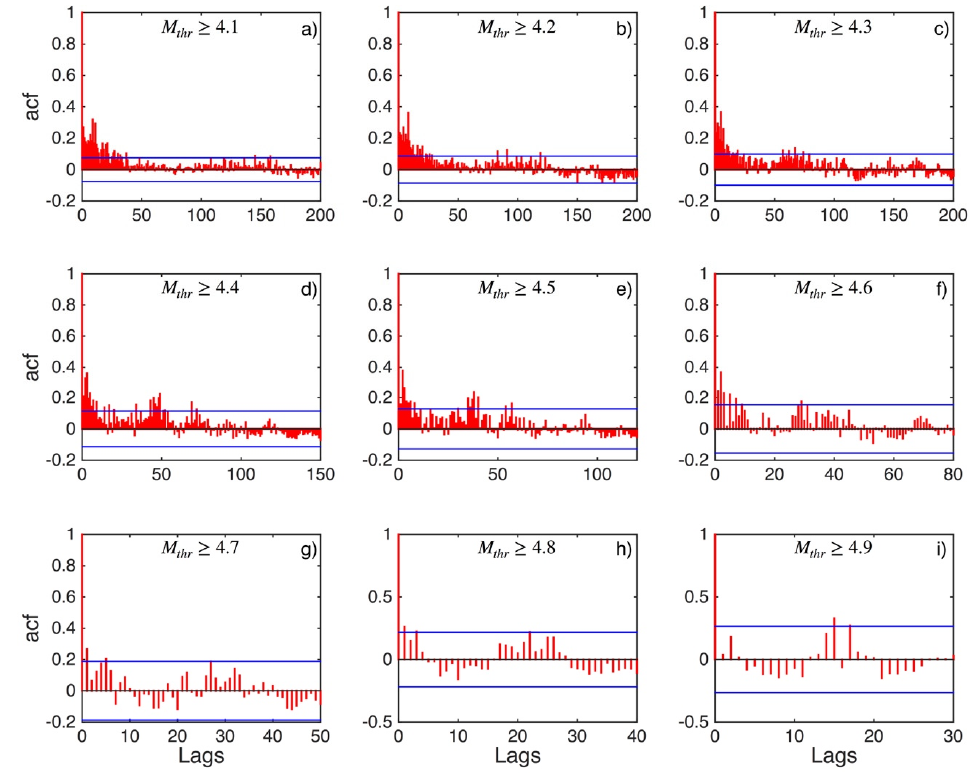
Figure A16. ACF values (red stems) and their 95% confidence intervals (blue lines) for Corinth Gulf (sub-area 7) for magnitude thresholds ( M thr ) varying from 4.1 to 4.9 (subplots a – i ).